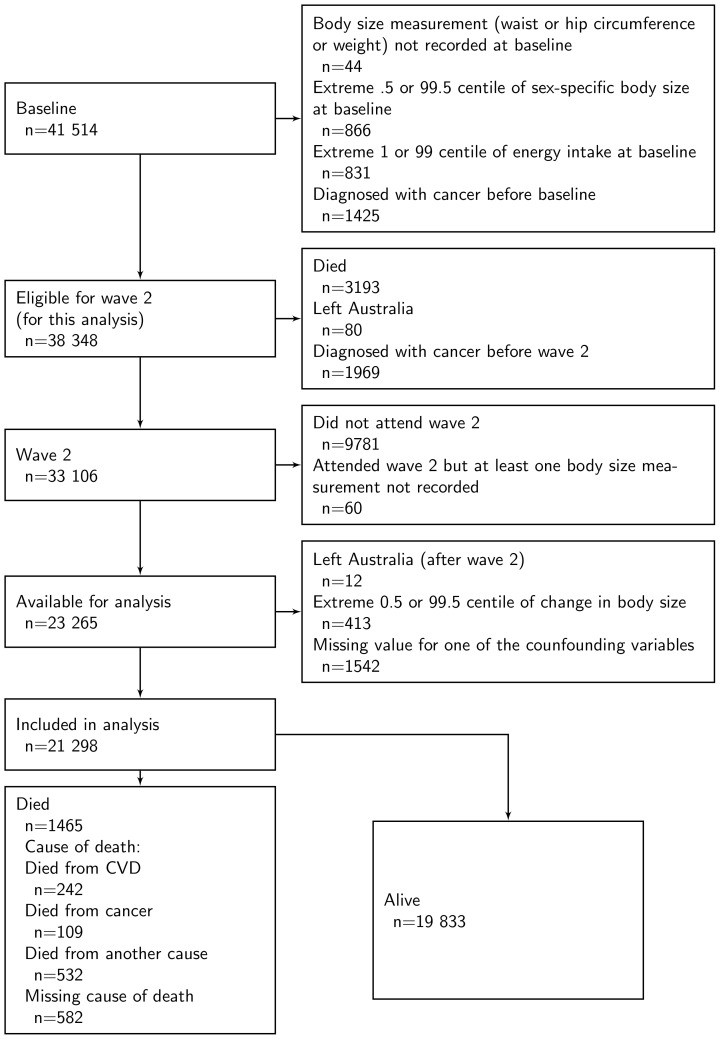
Flowchart of participants in the MCCS.